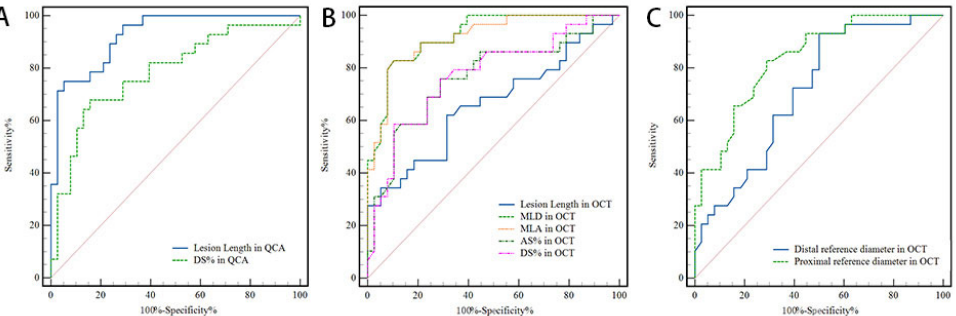
Figure 3. Comparison of receiver operating curves for the discrimination of coronary hemodynamic deficiency. ( A ) Comparison of receiver-operating curves for Lesion length and DS% in QCA; ( B ) Comparison of receiver-operating curves for Lesion length, MLA, MLD, AS%, DS% in OCT; ( C ) Comparison of receiver-operating curves for Distal and proximal reference diameters in OCT. ROC = receiver operating curve, QCA = quantitative coronary angiography, DS% = percent diameter stenosis, OCT = optical coherence tomography, MLA = minimal lumen area, MLD = minimal lumen diameter, AS% = percent area stenosis, OFR = optical flow ratio.